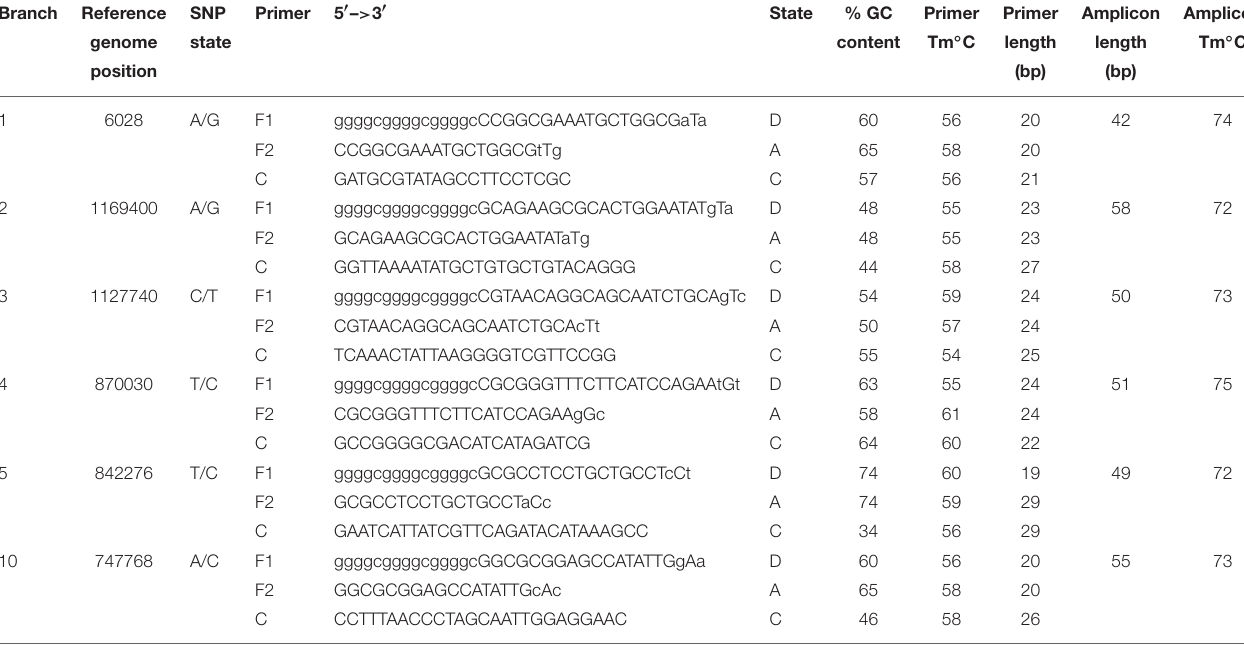
TABLE 2 | Assay design parameters for primer sets targeting 6 major branches of Brucella melitensis . Branch Reference